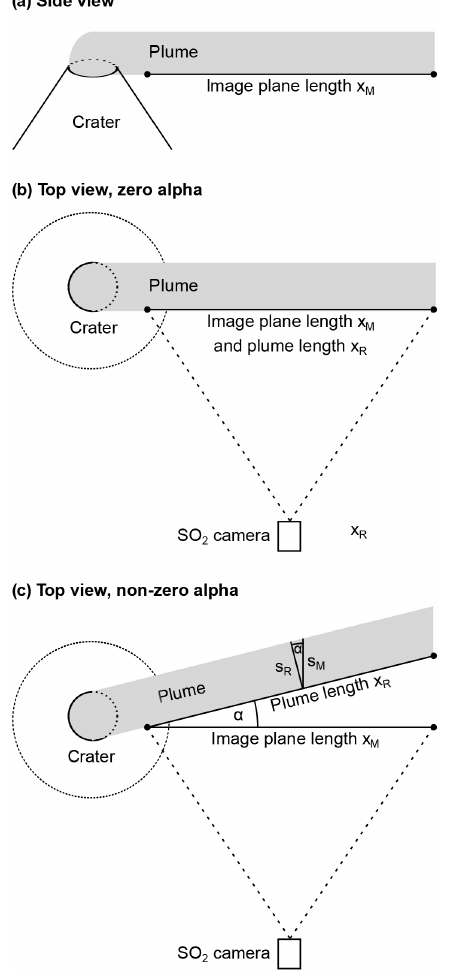
Figure 1. Schematic view on the influence of the inclination of the plume on the measured variables for the SO 2 flux determination for an SO 2 camera with a small FOV angle. (a) Side view of the volcanic plume and (b) top view of a volcanic plume parallel to the image plane, (c) top view of a plume inclined with respect to the image